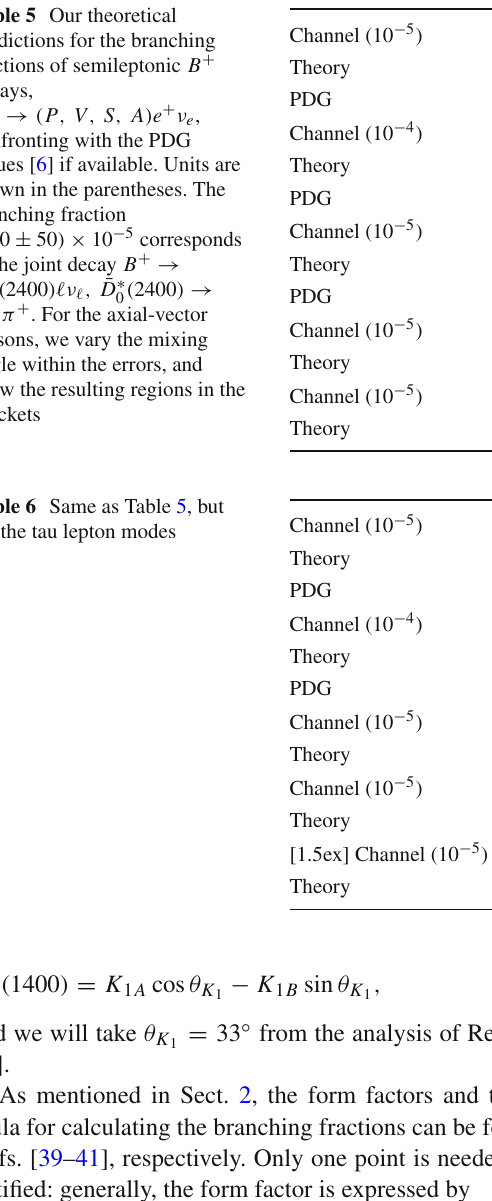
Table 5 Our theoretical predictions for the branching fractions of semileptonic B + decays, B + → ( P , V , S , A ) e + ν e , confronting with the PDG values [6] if available. Units are shown in the parentheses. The branching fraction ( 250 ± 50 ) × 10 − 5 corresponds to the joint decay B + → ¯ D ∗ ( 2400 )(cid:2)ν (cid:2) , ¯ D ∗ ( 2400 ) → 0 0 D − π + . For the axial-vector mesons, we vary the mixing angle within the errors, and show the resulting regions in the brackets